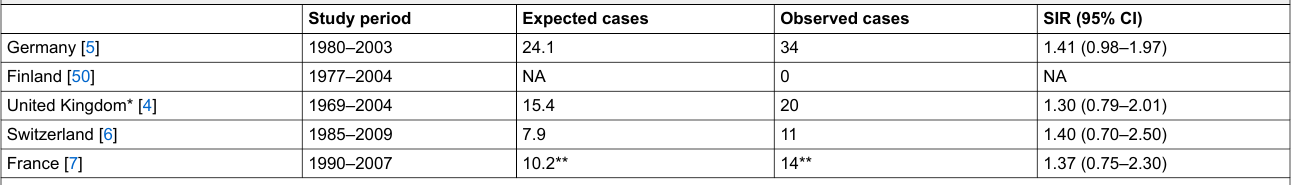
Table 1: Leukaemia risk in 0–4 year old children living within 5 km of a nuclear power plant: ecological analyses from recent studies in five countries. Study